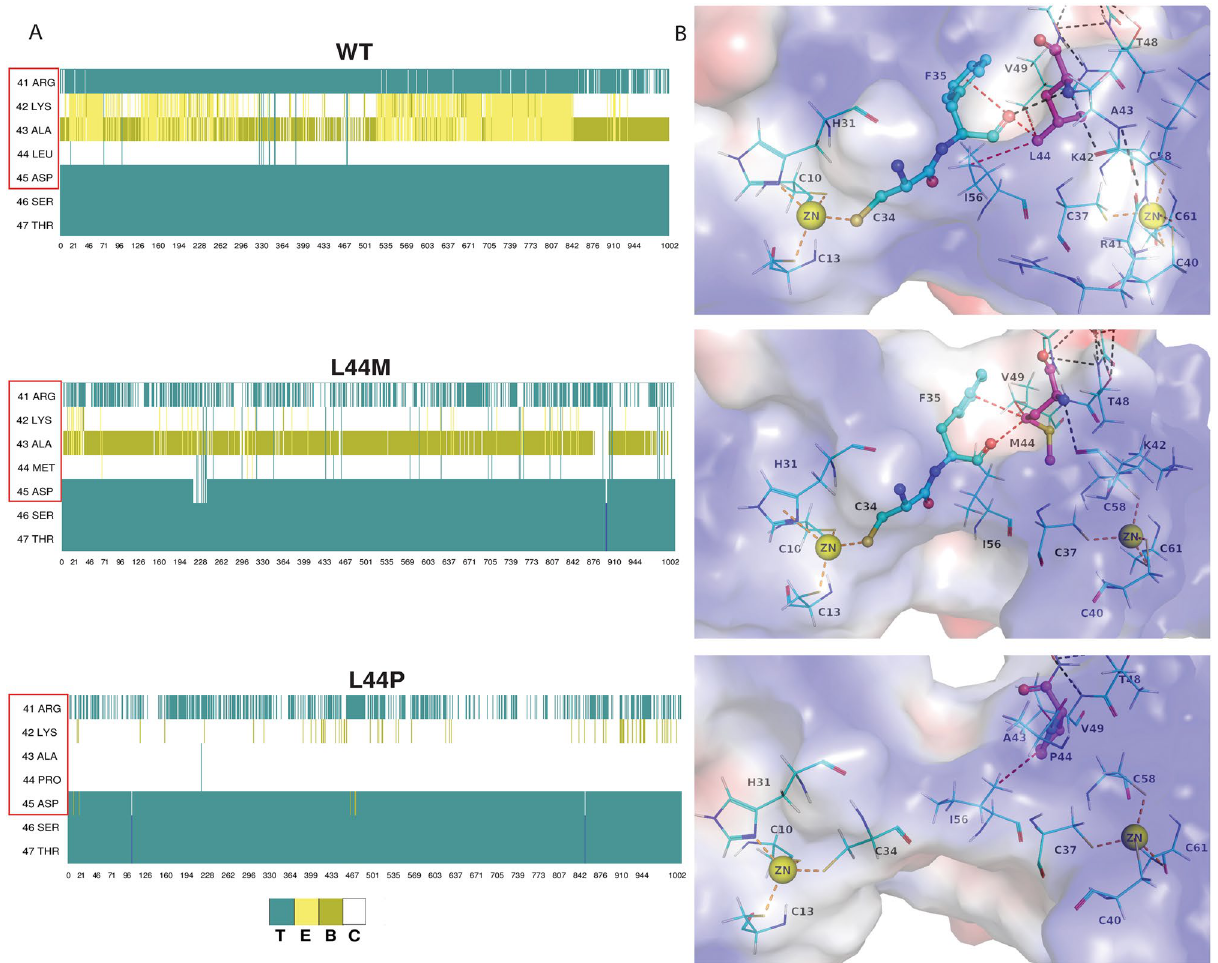
Figure 4. Secondary structural elements and residue interaction analysis of WT, L44M and L44P substitutions. ( A ) Timeline of secondary structure conformations in the trajectories of WT, L44M and L44P structures. In the representation, ‘T’ (aqua) corresponds to ‘Turn’, ‘E’ (yellow) indicates ‘Extended β-strand conformation’, ‘C’ (white) stands for ‘Coil’ (random coil) and ‘B’ (pea green) depicts ‘isolated bridge’. ( B ) Interactions in the region of position 44 of LIM1 domain. Hydrophobic (yellow color dash lines) and hydrogen bond (green color dash lines) interactions are highlighted for WT, L44M and L44P structures. ( C ) The electrostatic potential of WT, L44M and L44P structures, corresponding to zeroth snapshot of the dynamics simulations, are shown as a surface representation. Zn 2+ is indicated in yellow sphere and position 44 is highlighted in pink ball and stick